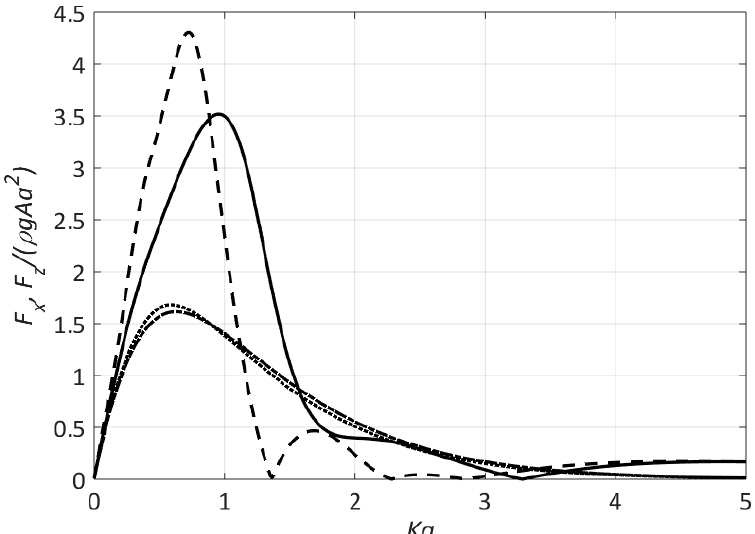
Figure 2. Magnitudes of the hydrodynamic loading acting on an oblate spheroid that approximates a sphere a / b ∼ 1 immersed at f / a ∼ 1 and f / a = 1.5. The sphere is subjected to regular wave action. Solid line: surge force f / a ∼ 1; dashed line: heave force f / a ∼ 1; chained line: surge force f / a = 1.5; dotted line: heave force f / a = 1.5 .